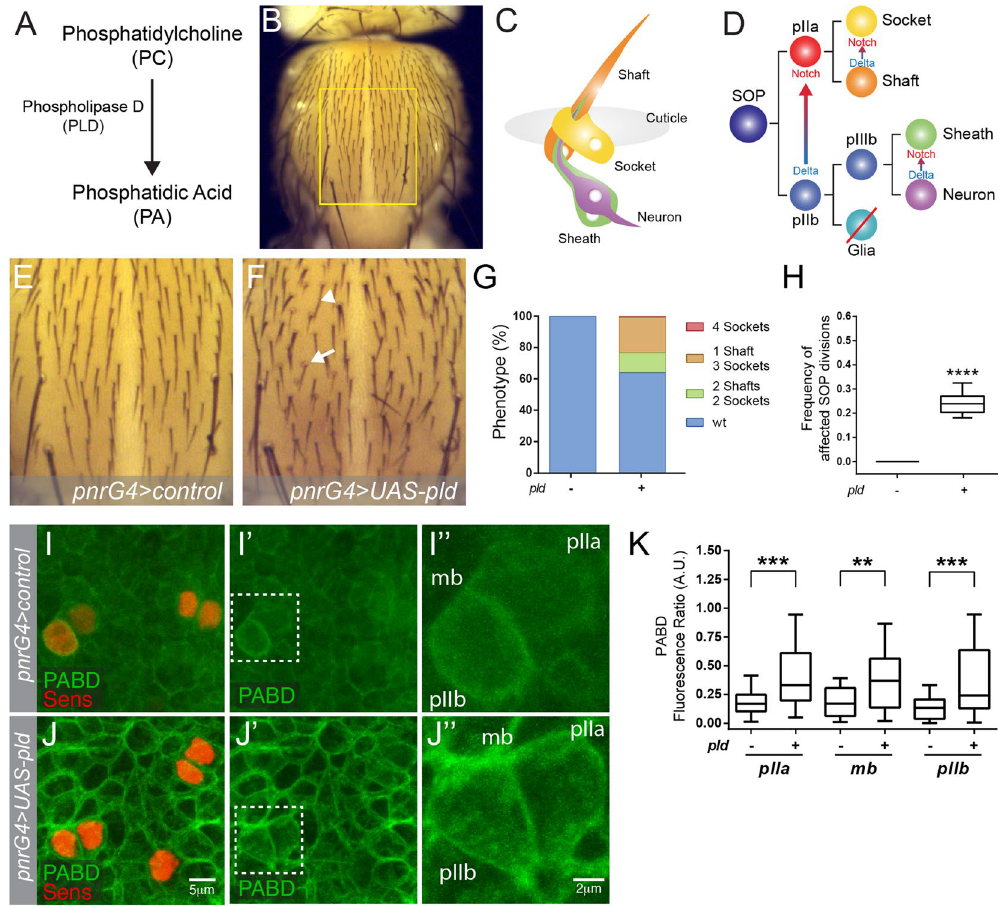
Figure 1. PLD-PA affects the cell-fates decisions during Sensory Organ development. ( A ) PLD uses PC as a substrate to generate PA. ( B ) Dorsal view of an adult fly thorax, yellow rectangle indicates the analyzed area. ( C ) The sensory organ (SO) is a mechanoreceptor composed of four cells. ( D ) Notch mediates binary cell- fate decisions of the SOP lineage. ( E ) Higher magnification of the analyzed area of a control fly. ( F ) Notum of a fly overexpressing PLD (PLD-GOF). The arrowhead indicates a SO with 2 shafts and 2 sockets. The arrow indicates a SO with 1sheath and 3socket. ( G ) Distribution of the 4 observable phenotypes in pnrG4 > pld notum. ( H ) Quantification of the frequency of divisions affected by the gain function of Notch (n = 10, p < 0.0001). ( I , J ″ ) Confocal projection of notum epithelium stained with senseless (red) and PABD-GFP (green). ( I ″ , J ″ ) Magnification of a dividing SOP, specifying each cell and the midbody. ( K ) Quantification of fluorescence ratio in both conditions (n = 23, ** p < 0.01, *** p < 0.001). The scale represents 5 µm ( I – I ′ , J – J ″ ) and 2 µm ( I ″ , J ″